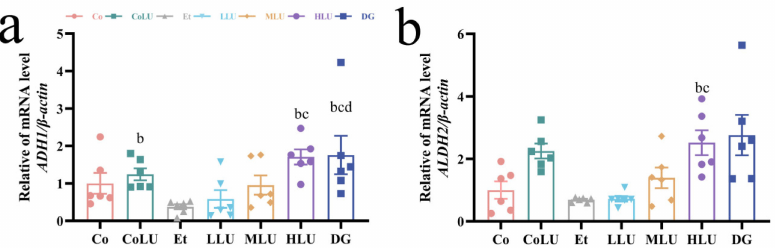
Figure 2. Effect of lutein on alcohol metabolism in the liver. The gene expression levels of ADH1 ( a ) and ALDH2 ( b ) in the liver ( n = 6/group). The data were shown with mean ± SEM. Co: normal control group; CoLU: the medium-dose lutein control group; Et: ethanol model group; LLU: the low-dose lutein intervention group; MLU: the medium-dose lutein intervention group; HLU: the high-dose lutein intervention group; DG: positive control group. b p < 0.05 vs. Et group, c p < 0.05 vs. LLU group, d p < 0.05 vs. MLU